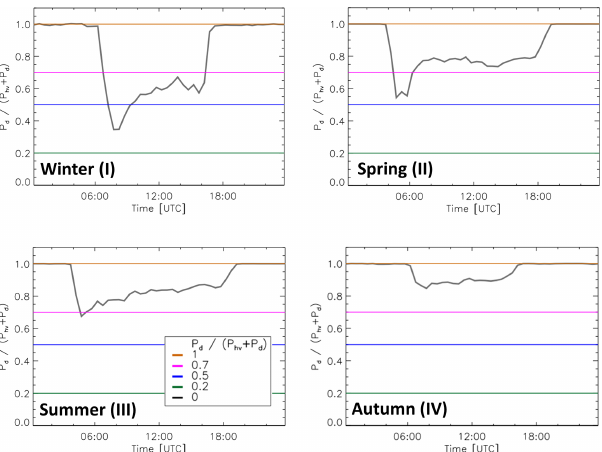
Figure 9. The median ratio of dark to total atmospheric OH pro- duction rates during four JULIAC periods (grey lines). P d is the calculated reaction rate of HO 2 with NO (Reaction R4), and P hv is the OH production rate from the photolysis of ozone (Reactions R1 and R2) and HONO (Reaction R3). For the calculations, measured quantities (300s averaged) were used (Table 2). The coloured hor- izontal lines denote the same ratios of dark to total OH production rates as used in Figs. 7 and 8.